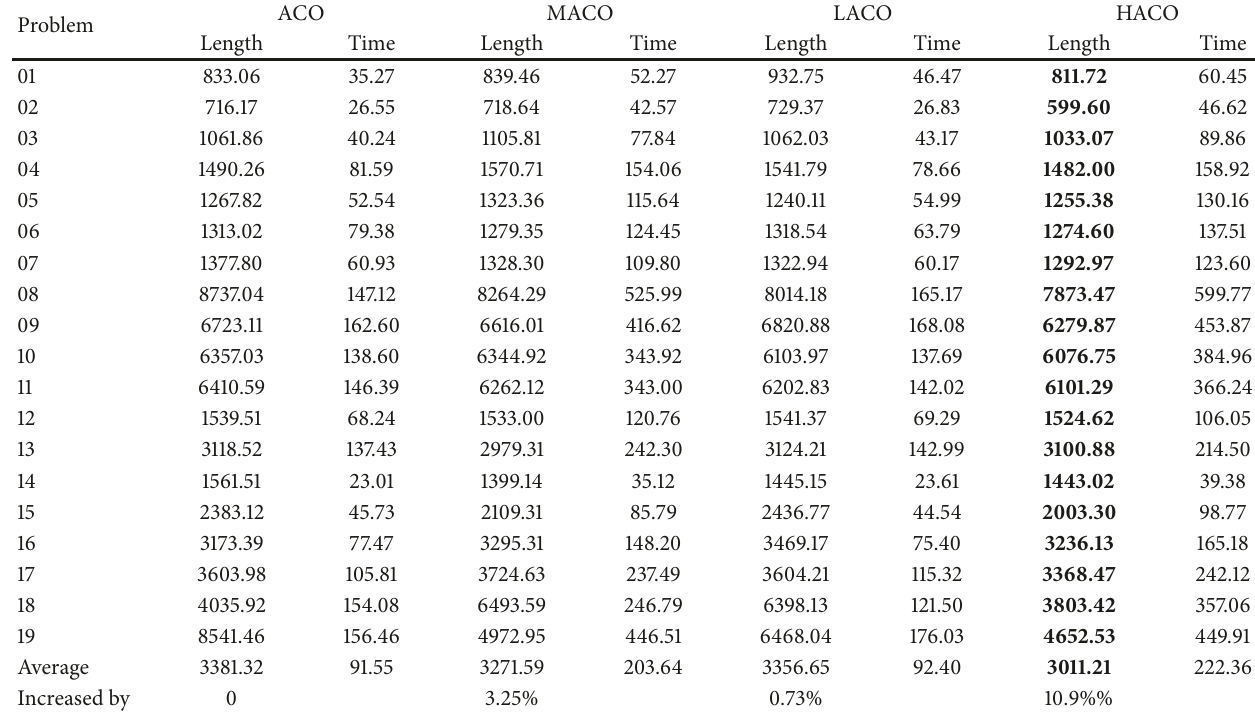
Table 3: Comparisons based on four different ACO.